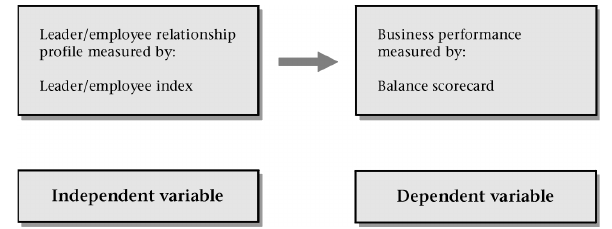
Figure 2: Independent and dependent variables